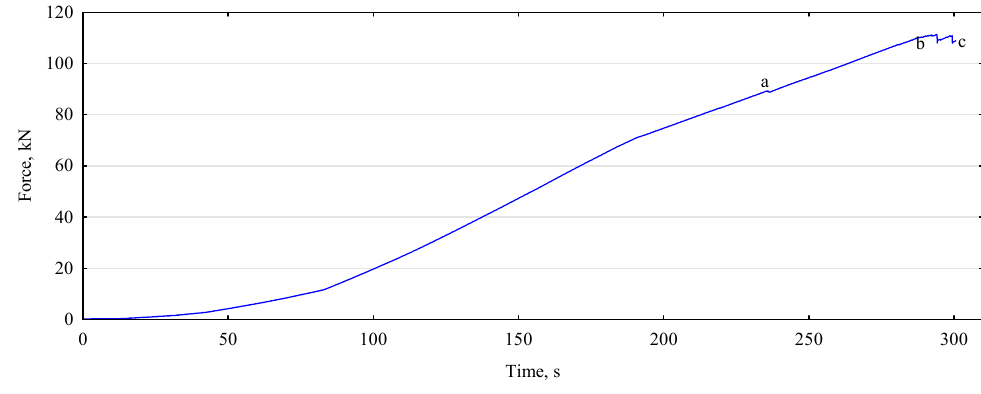
Figure 8. Process of loading the P34 beam to failure. Table 5. Statistical analysis of moisture content in tested pine beams.